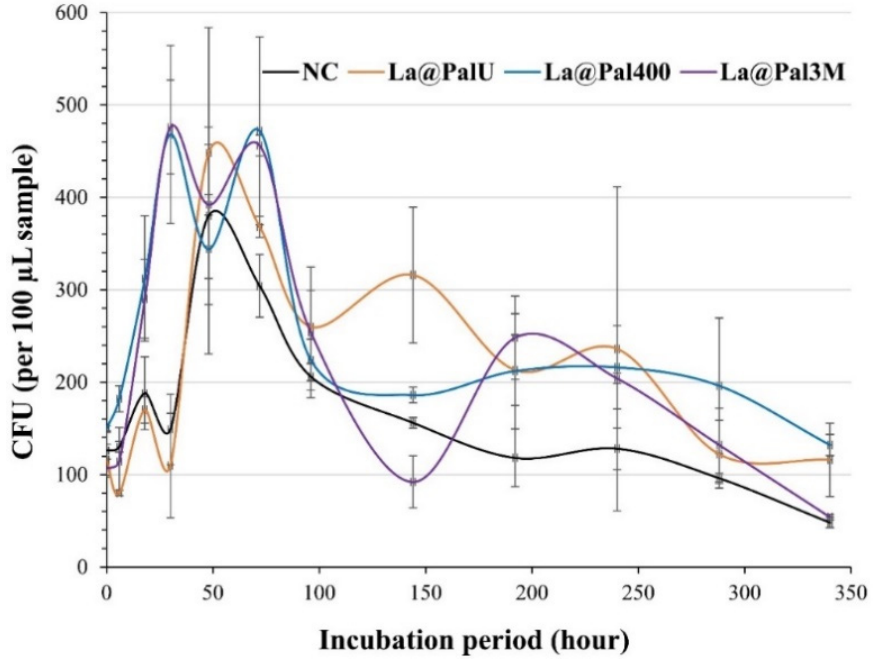
Figure 8. Bacterial growth in control lake water and the presence of various modified palygorskite materials. The growth is presented as the colony-forming unit per 100 µ L of the aqueous suspension. NC = no clay (control).